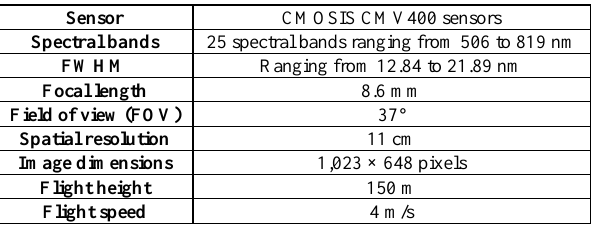
Table 2. Characteristics of the camera, flight and